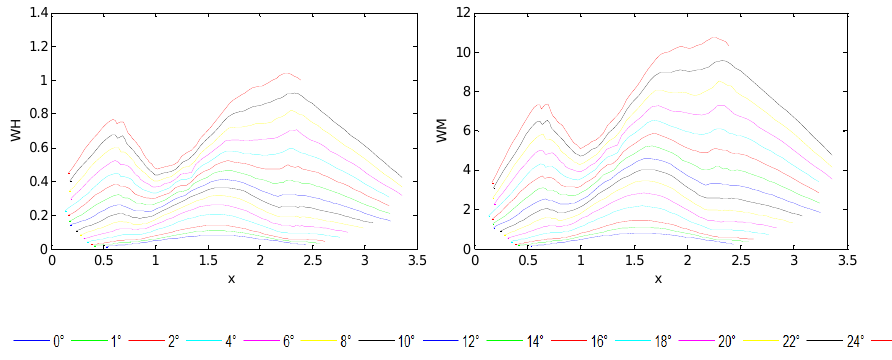
Figure 5. W H and W M curves under the improved Suter transformation method. The W H and W M curves can be represented as Equations (8) and (9).